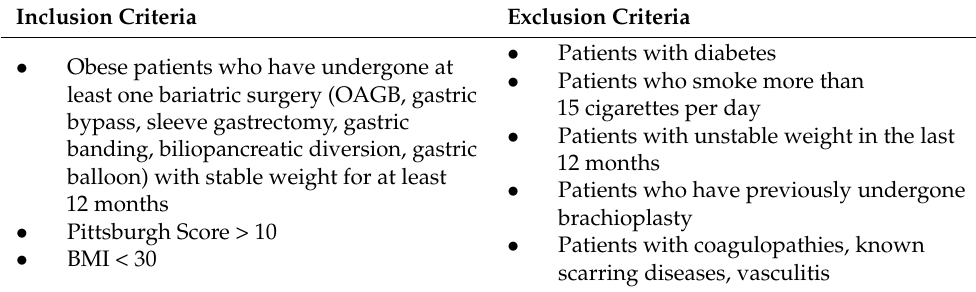
Table 1. Inclusion and exclusion criteria.